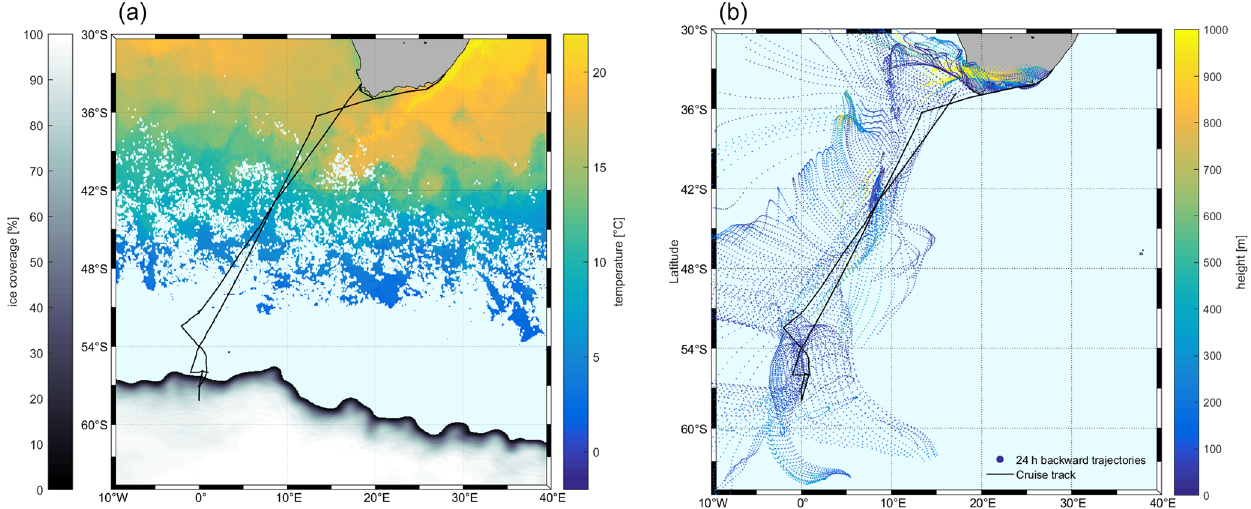
Figure 1. The cruise track (black) superimposed on satellite data. (a) Sea surface temperature (SST) and ice coverage (%). SST and sea ice data are derived from satellite (12 July to 12 August 2019; SST – Naval Oceanographic Office, 2008; sea ice data – UK Met Office, 2012.); (b) 24h air mass back trajectories starting at 50m height from HYbrid Single-Particle Lagrangian Integrated Trajectory (HYSPLIT) using the meteorological fields from the National Centers for Environmental Prediction Global Data Assimilation System (NCEP GDAS). The color shows the average height of the